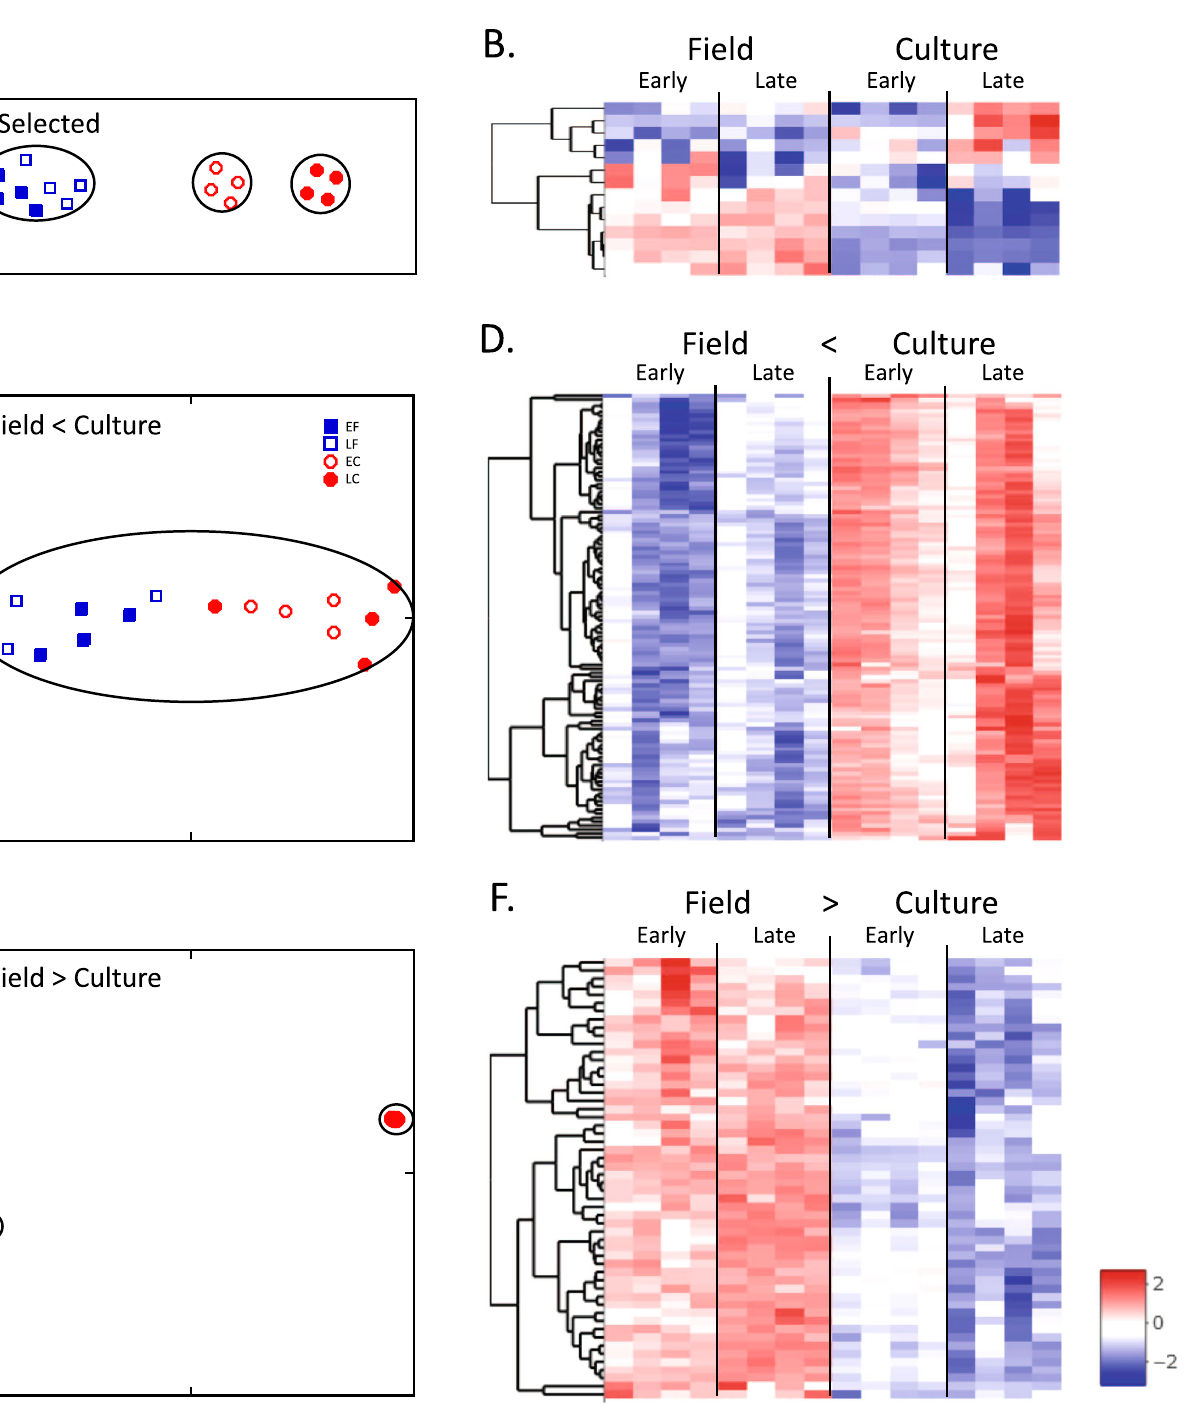
Fig. 9 “ Designer ” fi lters with high-responding genes to separate fi eld from culture transcriptional phenotypes. A , B Filter selecting genes based on evidence for involvement in diapause preparation, as described in the text. C – F Transcripts were selected from DEGs annotated with the GO terms ‘ oogenesis ’ (GO:0048477), ‘ fatty-acid biosynthesis ’ (GO:0006633) and ‘ RNA metabolic process ’ (GO:0016070). C – D Filter selecting transcripts having z- scores in all culture samples higher than any in the fi eld samples. E – F Filter selecting transcripts having z-scores in all fi eld samples higher than any in the culture samples. A , C , E t-SNE plots, perplexity = 5; max iterations 50,000; clusters identi fi ed by DBSCAN encircled. Key in ( C ) applies to all t-SNE plots: EF early fi eld, LF late fi eld, EC early culture, LC late culture; B , D , F ordered